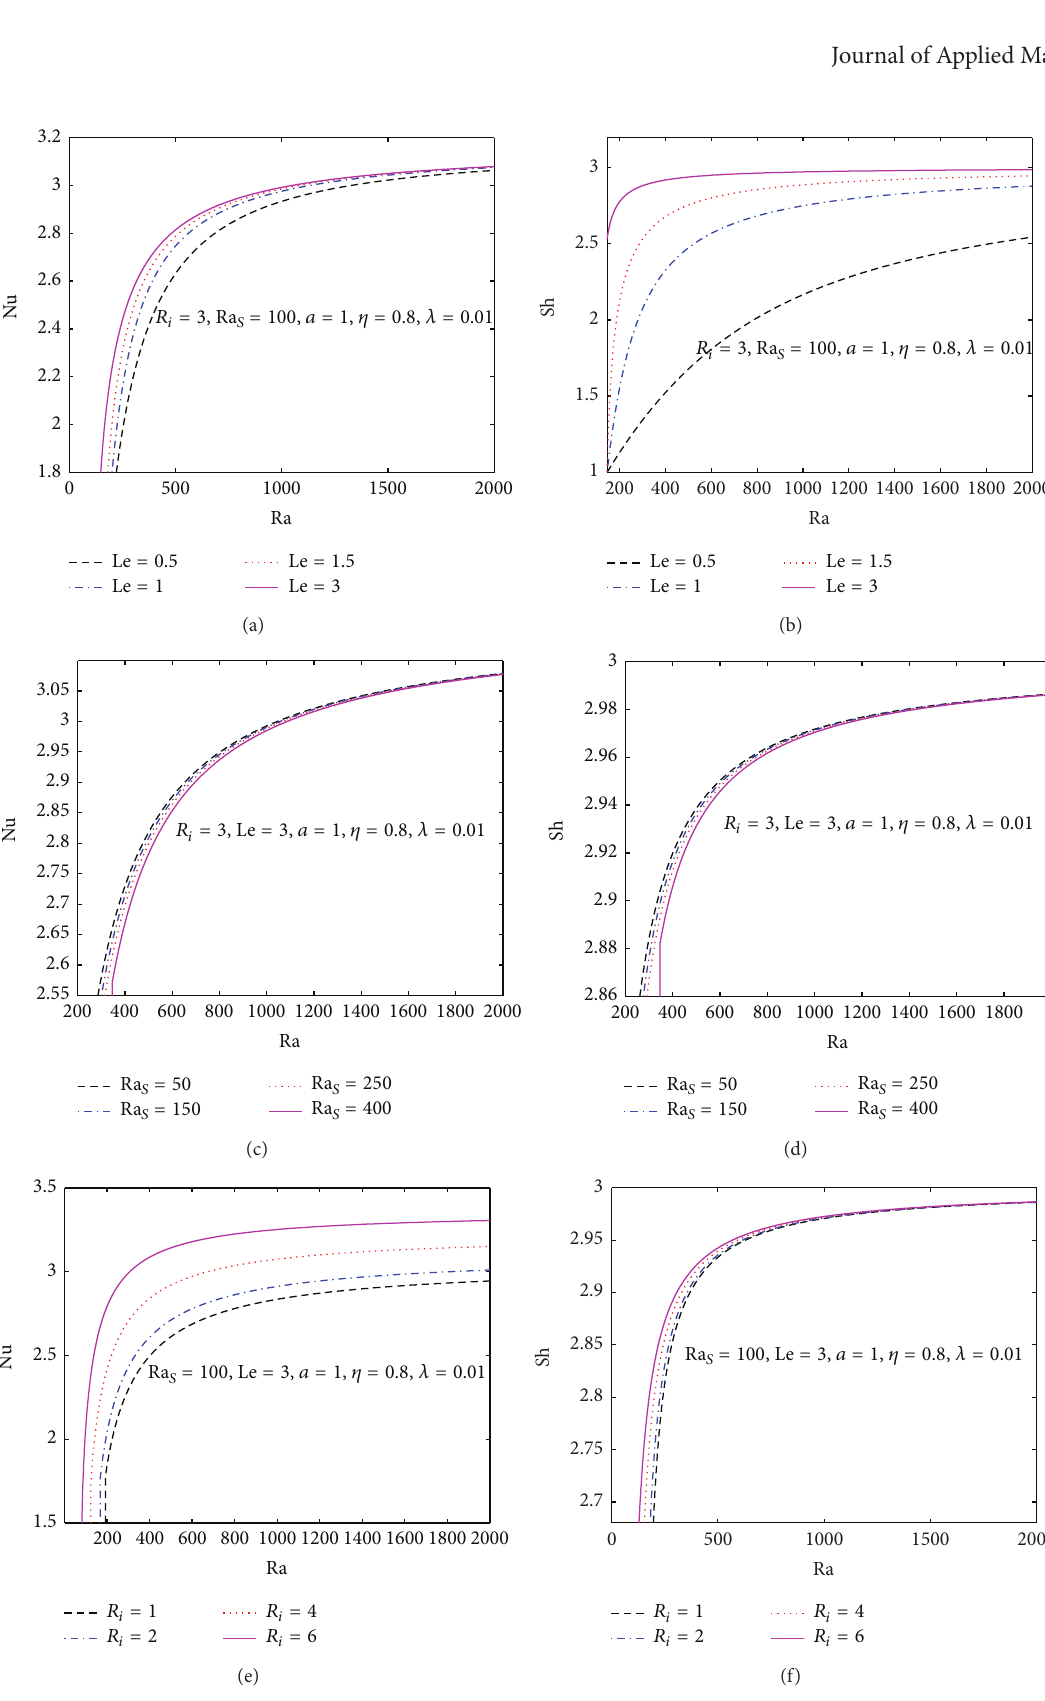
Figure 2: Variation in Nusselt number Nu and Sherwood number Sh with respect to Rayleigh number Ra 𝑇 for steady nonlinear stability at different values of